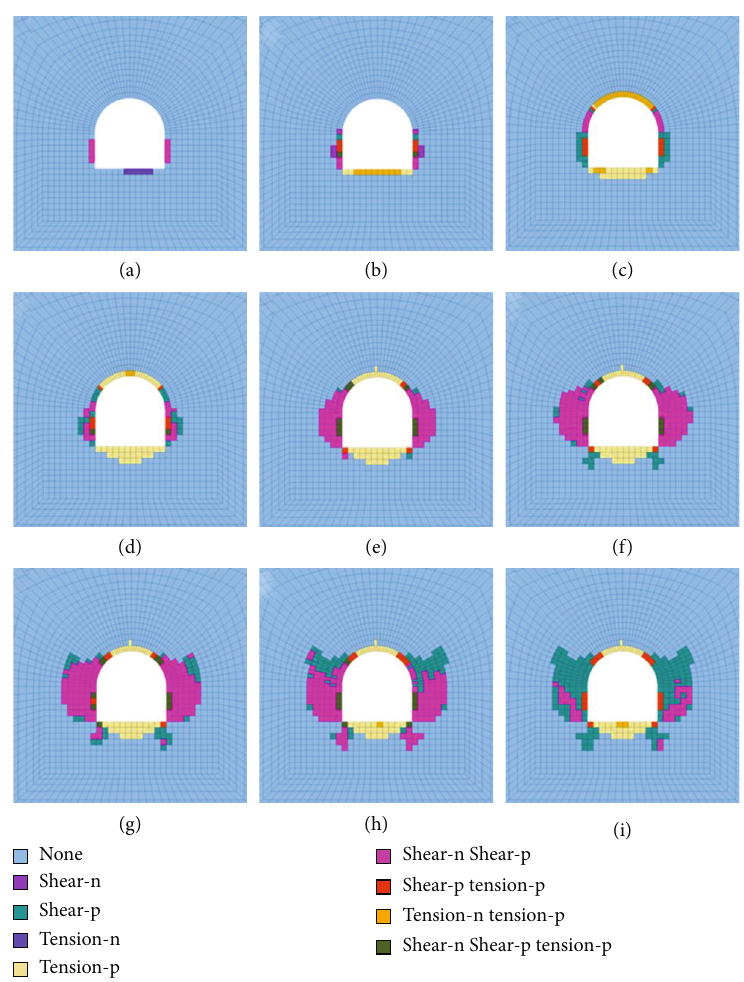
Figure 10: Development process of the plastic zone in isotropic surrounding